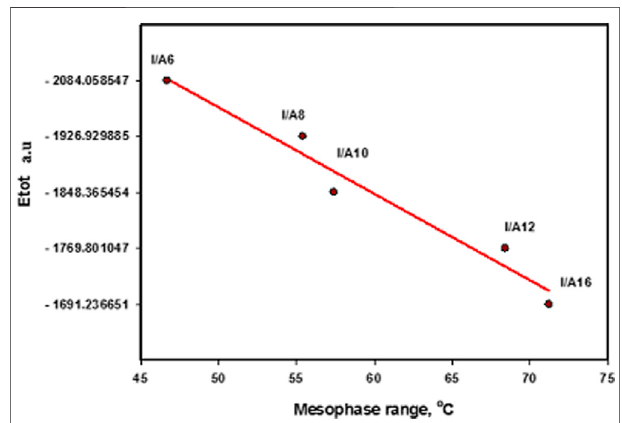
FIGURE 13 | Relationship between the sum of the electronic and thermal energies with the smectic mesophase stability of H-bonded complexes, I/An.